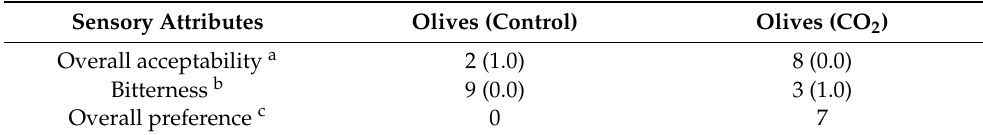
Table 1. Sensory assessment of olives stored under a CO 2 atmosphere and regular atmospheric conditions (control).